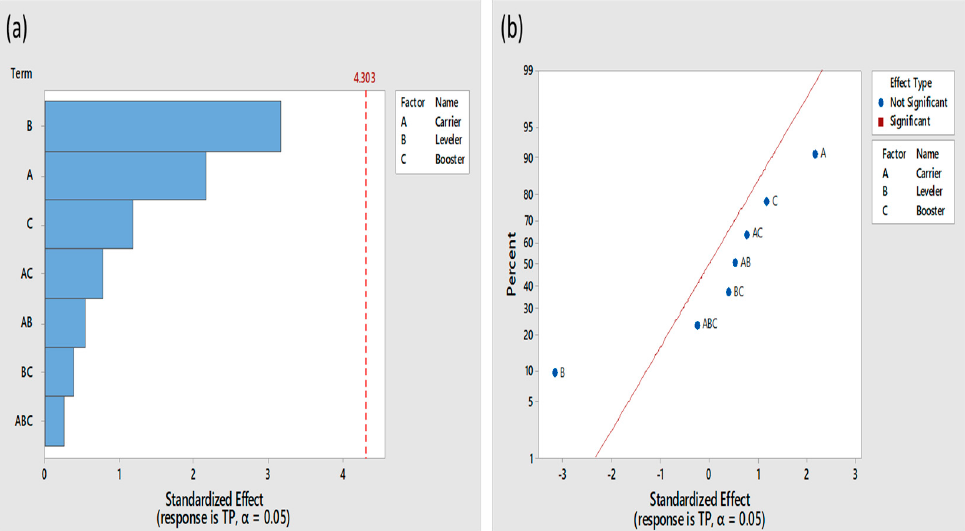
Figure 6. ( a ) Pareto chart and ( b ) normal probability plot of the standardized effects of additives on throwing power. throwing